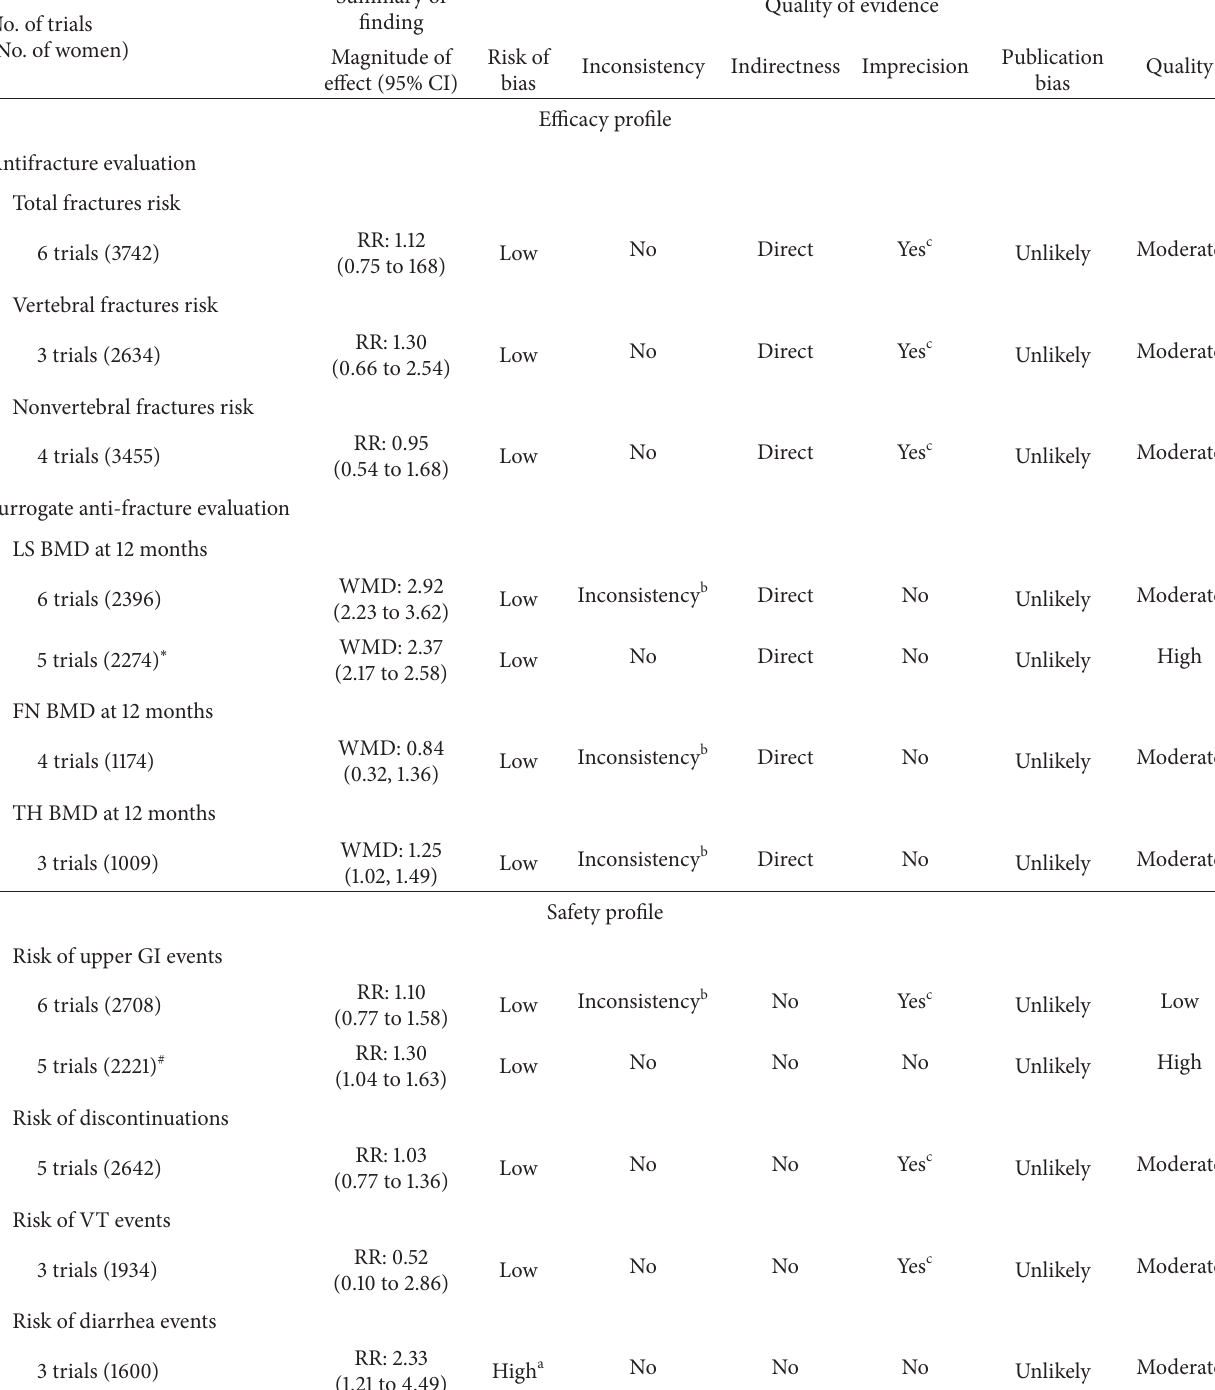
Summary of Quality of evidence finding Magnitude of Risk of Inconsistency Indirectness Imprecision Publication effect (95% CI) bias Efficacy profile